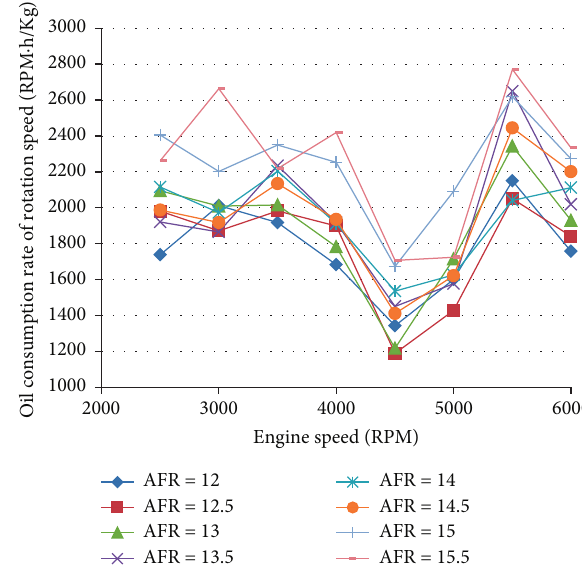
Figure 13: Output power at different engine speeds.